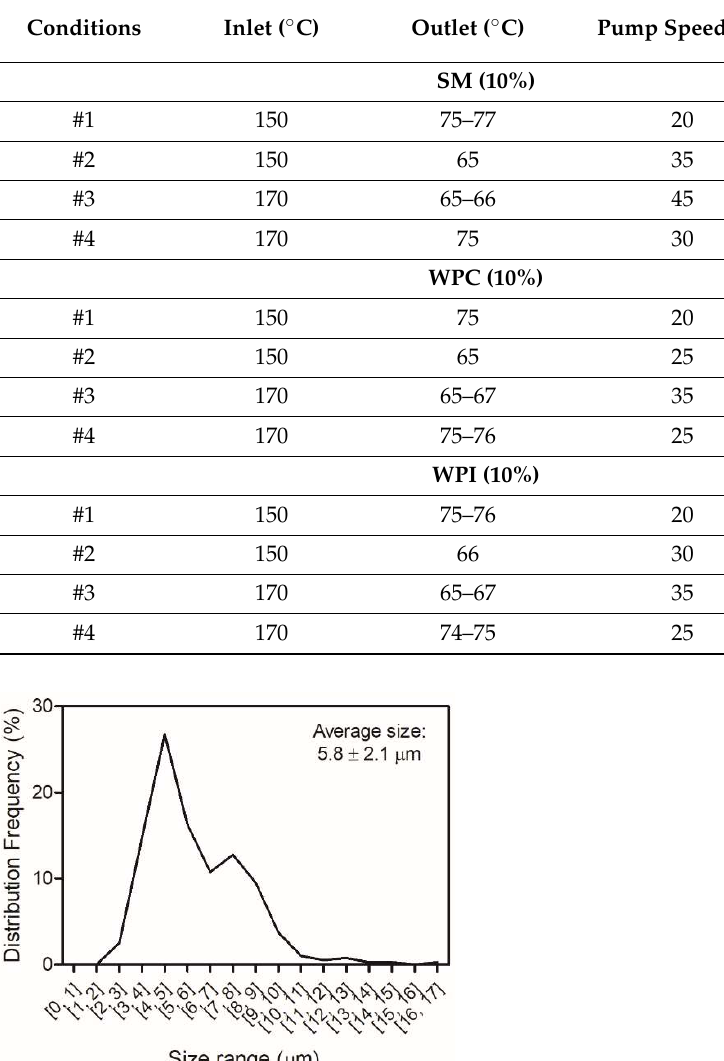
Figure 4. Viability of spray-dried A. muciniphila DSM 22,959 exposed to simulated GIT conditions for 5 h. The assessment was performed at defined timepoints after aerobic, refrigerated storage: 1 (circles); 14 (squares); 28 (triangles); 45 (hexagons); and 60 (diamonds) days. GP = end of the gastric phase; IP = end of the intestinal phase. Regarding the survivability of the microencapsulated A. muciniphila cells to the GIT conditions, the final cell counts remain mostly similar to those from the beginning of the GIT passage simulation (Figure 4 and Table S2). A particular stabilization effect can be observed from storage from day 28 onwards, with the cell counts remaining steady throughout all the stages of the GIT passage (Figure 4 and Table S2). Thus, these results